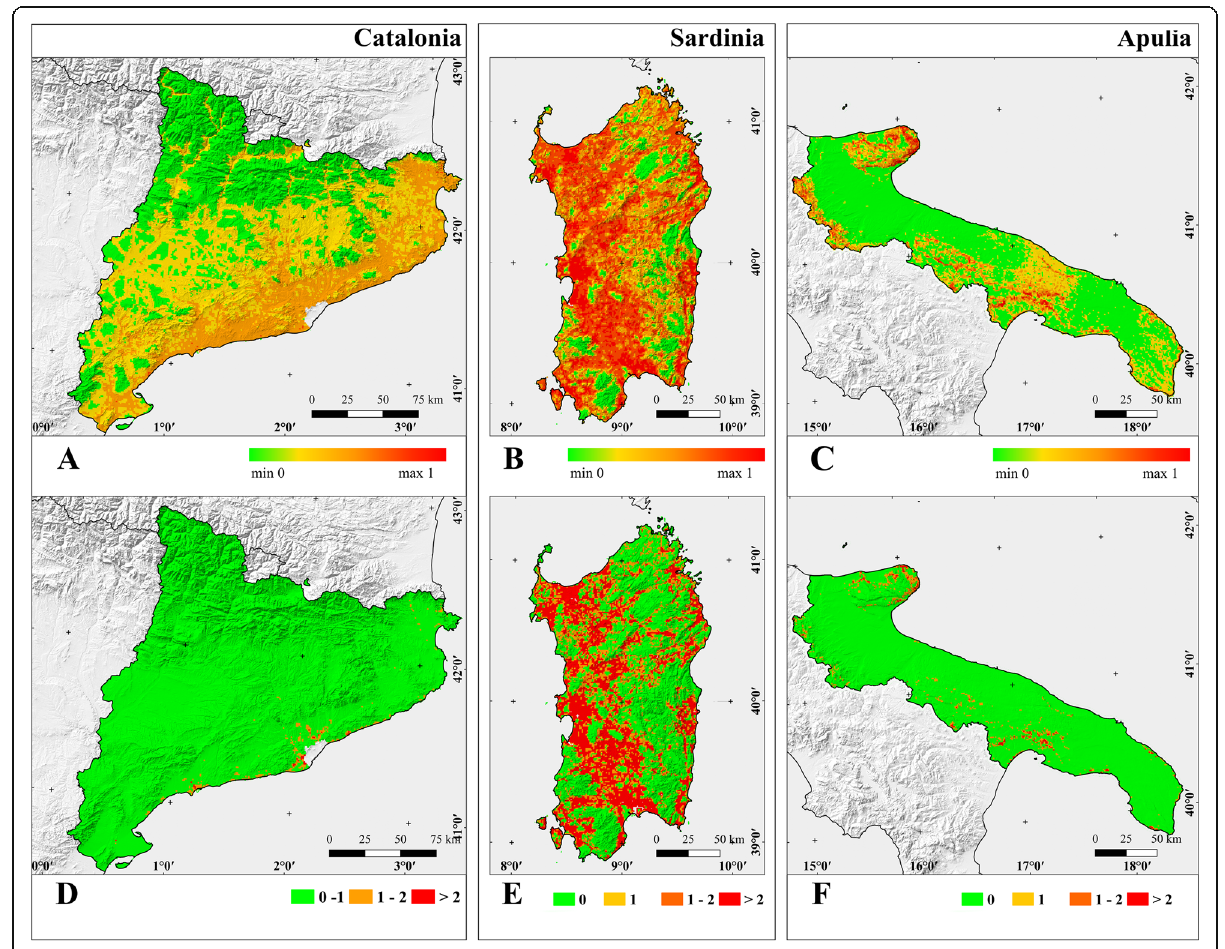
Fig. 5 Fire ignition maps: fire ignition probability ( a – c ) and frequency ( d – f ) for Catalonia, Sardinia, and Apulia, respectively. Low fire ignition probability and frequency are shown in green, while high fire probability and frequency are shown in red; gray indicates no